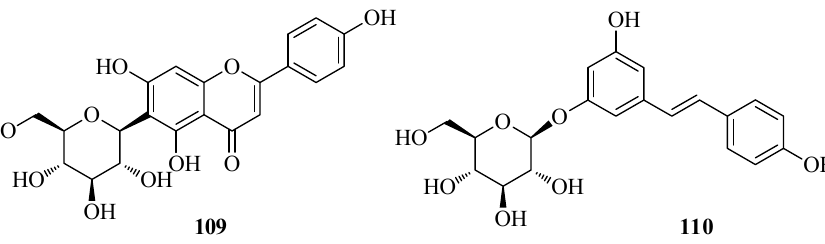
Figure 8. Characteristic phenolic compounds isolated from Iris persica .